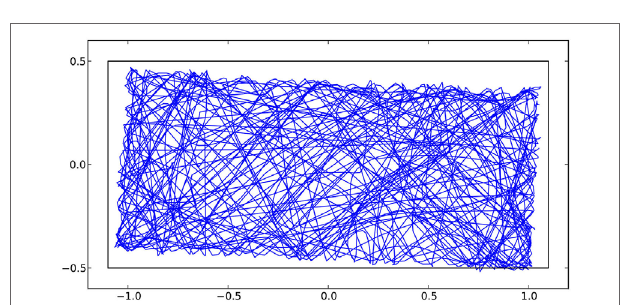
FigUre 4 | Schematic search trees for a one step search (a) , full search (B) , depth-only search (c) resulting from multistep